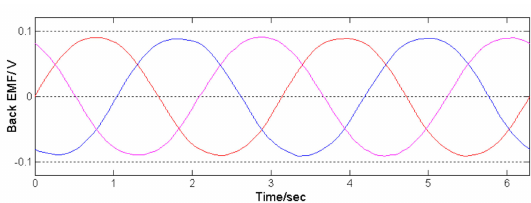
Figure 11. Harmonic currents of proposed method.